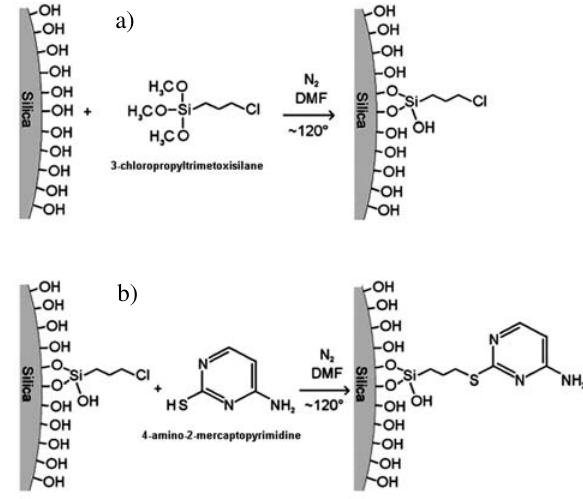
Figure 4. Schematic representation of the silanization step (a) and of the anchoring of the ligand to the surface of the mesopo- rous